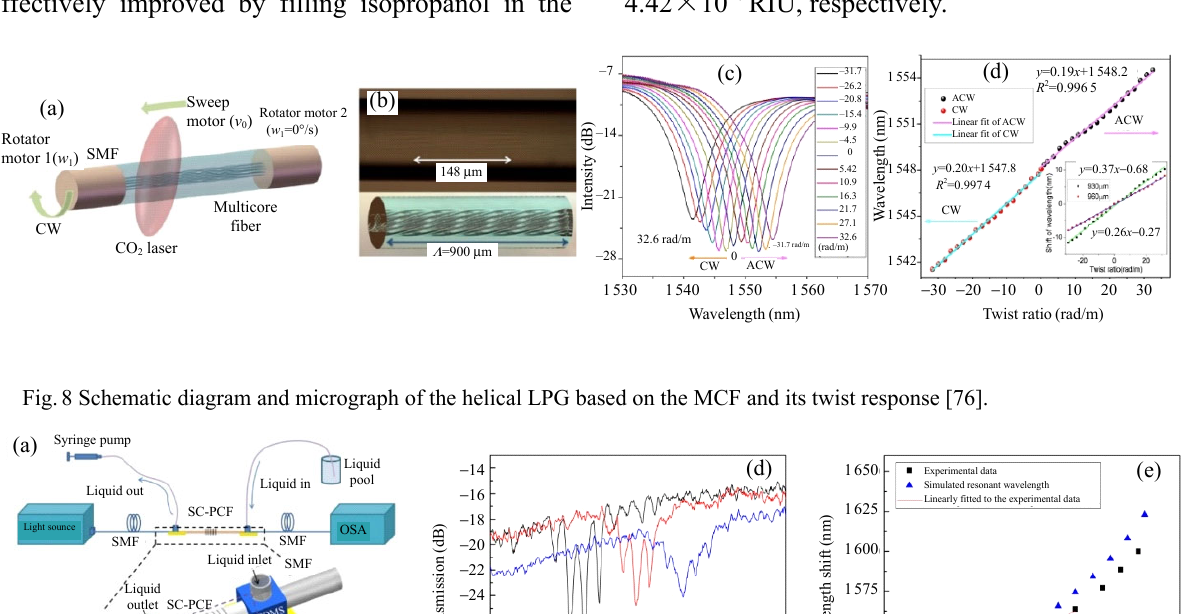
Experimental data Simulated resonant wavelength Linearly fitted to the experimental data